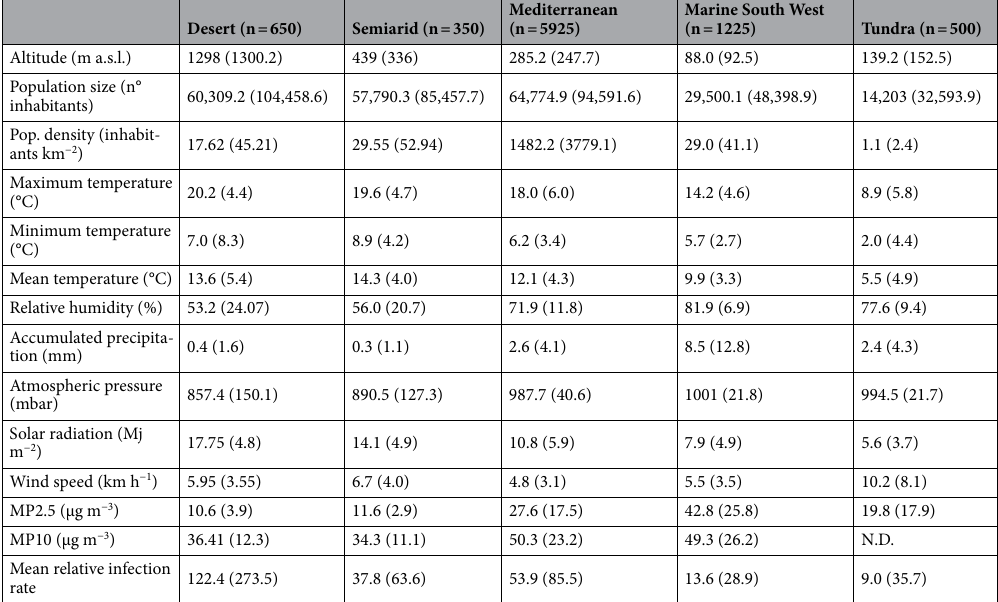
Table 1. Mean values (standard error) of the variables recorded between February 23 to August 16, 2020 in relation to climates. N.D. no